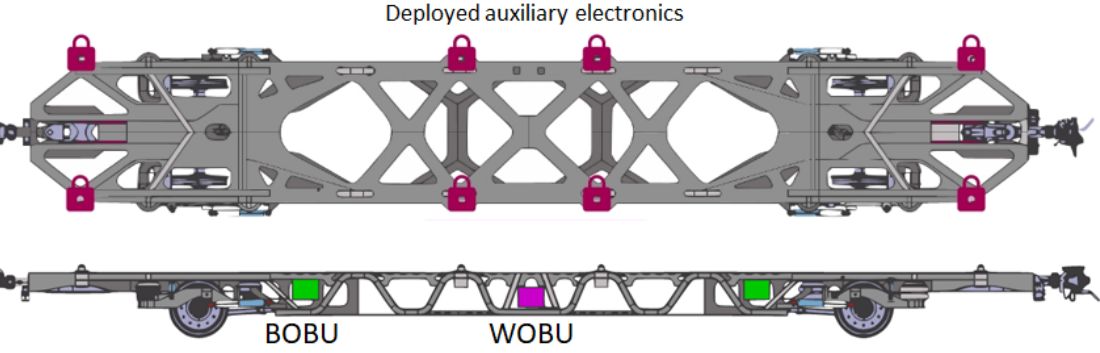
Figure 1. Telematic subsystems deployed on a freight wagon, by example of the Extended Market Wagon developed in the project